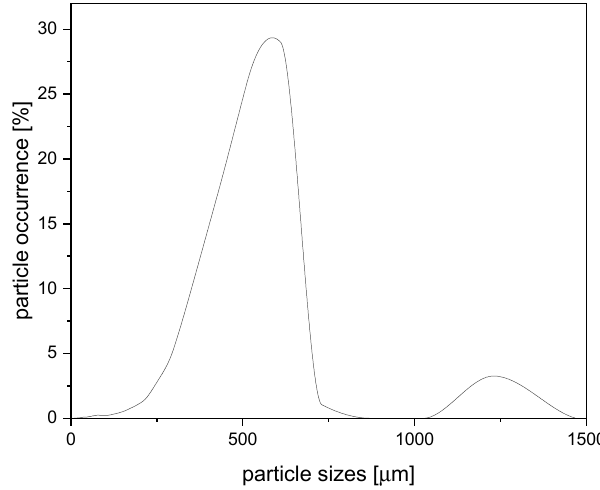
Figure 1. Particles size distribution of rubber filler. Reprinted by permission from Springer Nature Customer Service Centre GmbH: Springer Nature, SN Applied Sciences, A new approach to the structure-properties relationship evaluation for porous polymer composites, M. Cerny et al., 2020, doi:10.1007/s42452-020-2479-8 [SN Appl. Sci.], https://www.springer.com/journal/42452, accessed on 23 August 2022.